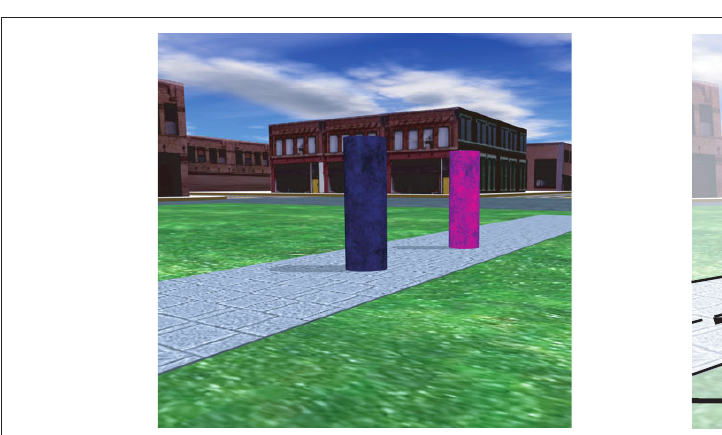
rewards” trace. (B) Root mean squared error error between the true rewards and the reward estimates of all behaviors over episodes. The three curves correspond to the different learning rates β in Eq. 15. (C) Root mean squared error between the true value function and the learned value functions of all behaviors over